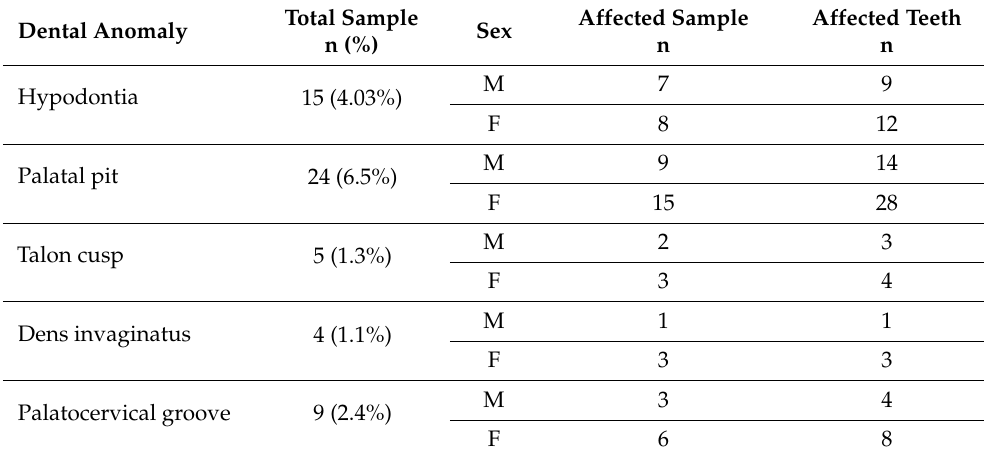
Table 2. The distribution of various dental anomalies of permanent maxillary lateral incisors among males and females.